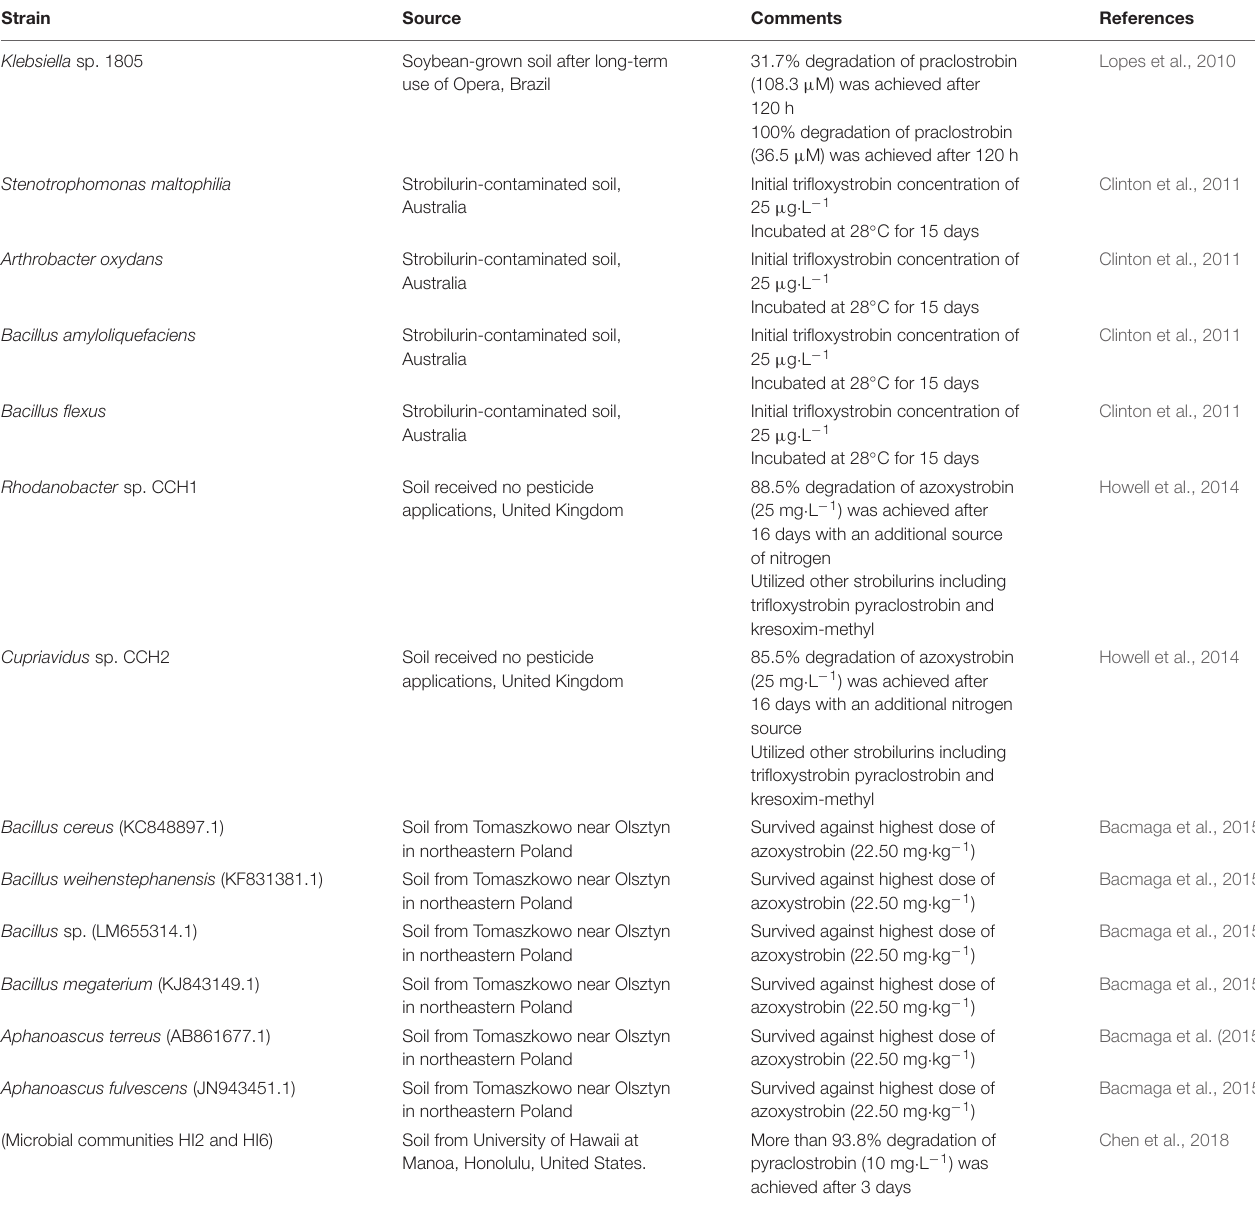
TABLE 1 | Strobilurin-degrading microbes and microbial communities.